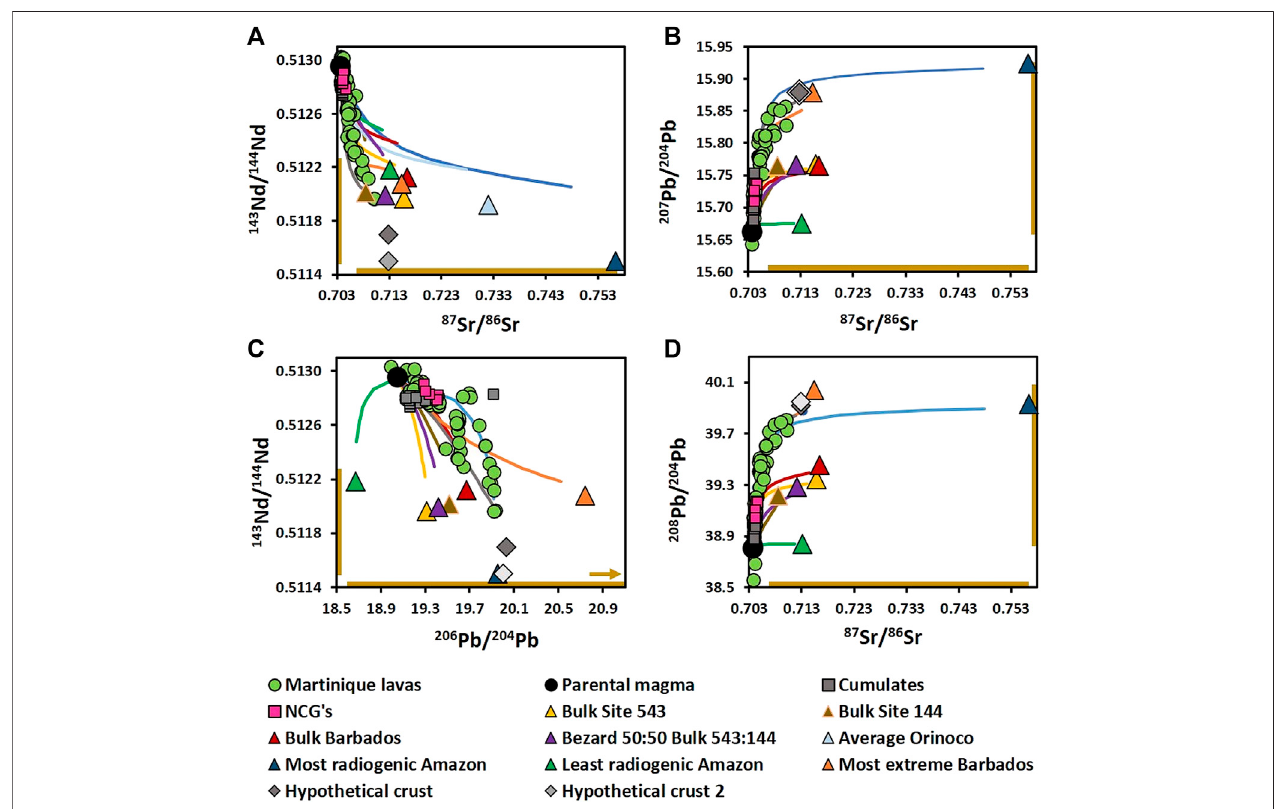
FIGURE10|(A) 87 Sr/ 86 Srvs. 143 Nd/ 144 Nd, (B) 87 Sr/ 86 Srvs. 207 Pb/ 204 Pb, (C) 206 Pb/ 204 Pbvs. 143 Nd/ 144 Ndand (D) 87 Sr/ 86 Srvs. 208 Pb/ 204 Pb,forMartiniquelavas, plutonicxenoliths (thisstudy) and endmembersused inAFCmodelingfrom Table3 .Datasourcesasper Table3 and Figure 8 .Foralldatapoints, uncertainty (2SE)is smallerthansymbolsize.Brownbarsalongaxesshowrangeofisotopiccompositionsofsedimentspotentiallyequivalenttothoseinthearccrustfrom Figure8 .Colored curves correspond to AFC models for each crustal end member, shown in detail in Figure 11